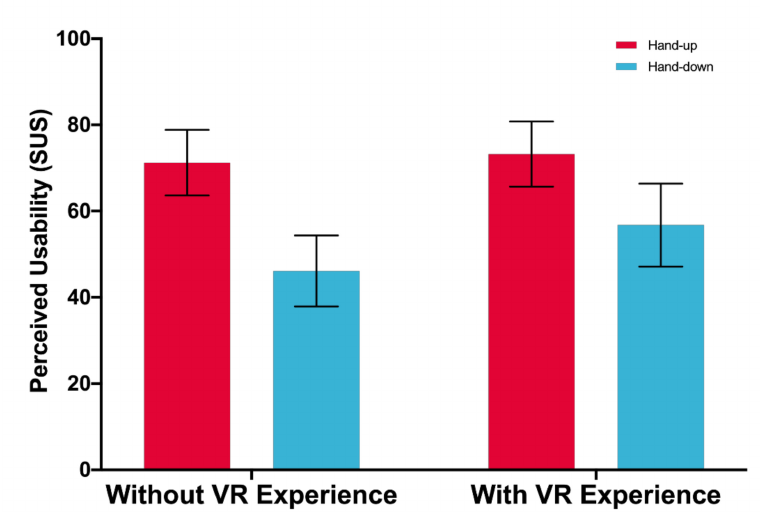
Figure 7. Perceived usability (100 = Highest). Error bars represent 95%